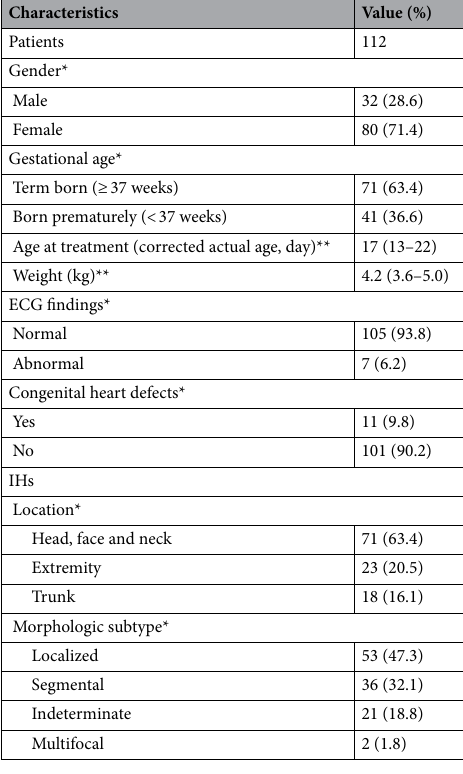
Table 1. Baseline characteristics of patients and IH. ECG, electrocardiogram; IH, infantile hemangioma. *Values are presented as a number (percentage). **Values are presented as a median (interquartile